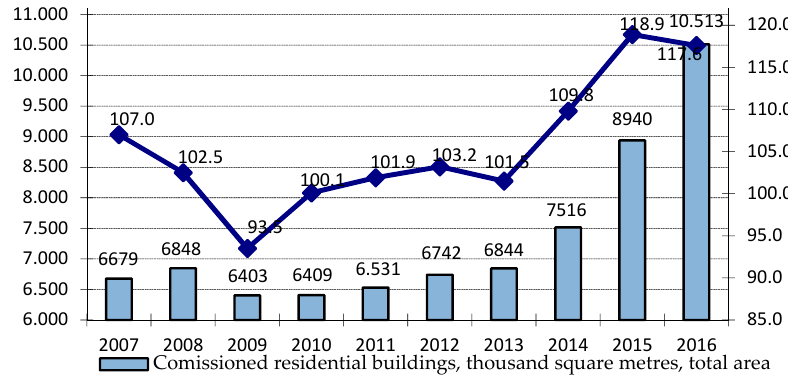
Figure 1. Dynamics of the main indicators of construction activities in Kazakhstan [5].